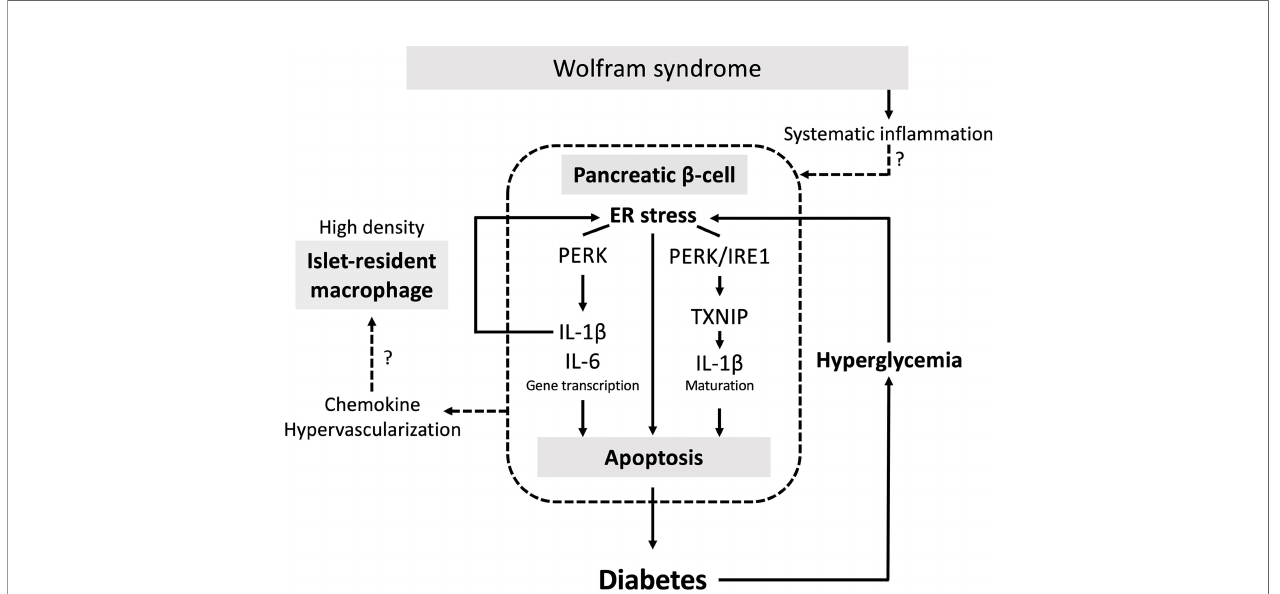
FIGURE 7 | The vicious cycle of in fl ammation and ER stress accelerates the progression of diabetes in Wolfram syndrome. Schematic of the relationship between ER stress and sterile in fl ammation in Wolfram syndrome (WS). Diabetes in WS is caused by terminal ER stress-induced pancreatic b -cell apoptosis. Hyperglycemic conditions of WFS1 -de fi cient pancreatic b -cells enhance terminal ER stress and induce sterile in fl ammation. Experimental high-glucose condition induces pro- in fl ammatory cytokine gene transcription via the PERK pathway and enhances TXNIP-mediated IL-1 b processing through the PERK and IRE1 a pathways. This high- cytokine condition accelerates ER stress-mediated cell death and upregulates the pro-in fl ammatory cytokine gene expression in WFS1 -de fi cient pancreatic b -cells. Secreted chemokines or the hypervascularized environment in the WS islets may cause cell-nonautonomous pancreatic b -cell in fl ammation, including M1- macrophage in fi